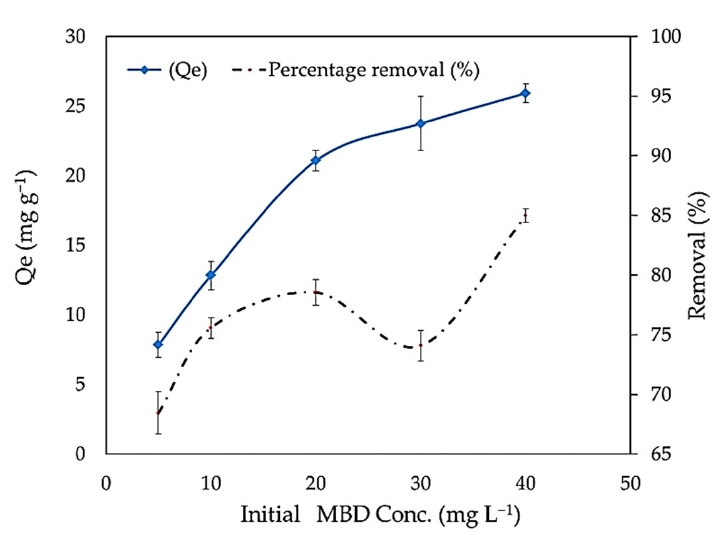
Figure 6. Impact of different methylene blue dye concentrations on adsorption capacity and removal percentages.